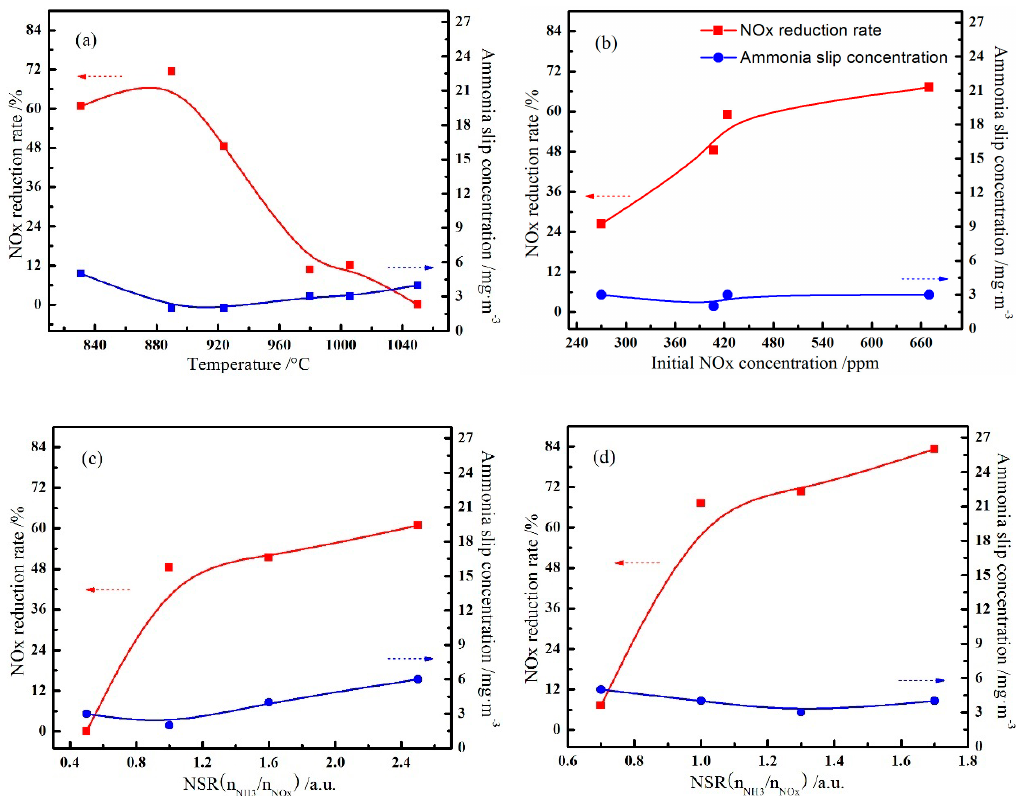
Figure 3. Effects of reaction conditions on the NO x reduction. (Reaction temperature ( a ); initial NO x concentration ( b ); the [NH 3 / NO x ] molar ratio with the initial NO x concentration was 390 ppm ( c ) and 680 ppm ( d )).